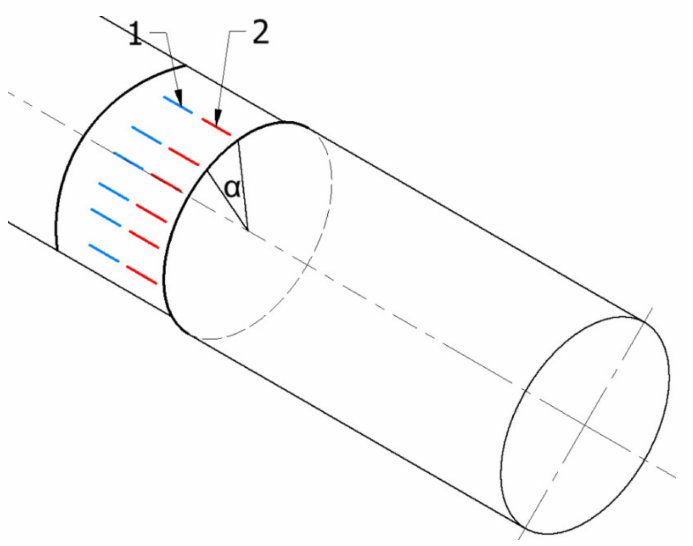
Figure 4. Schematically shown roughness measurement a series for one subzone (one tool type and cutting depth) ( 1 ), ( 2 )—place of measurements, ( α )—rotating